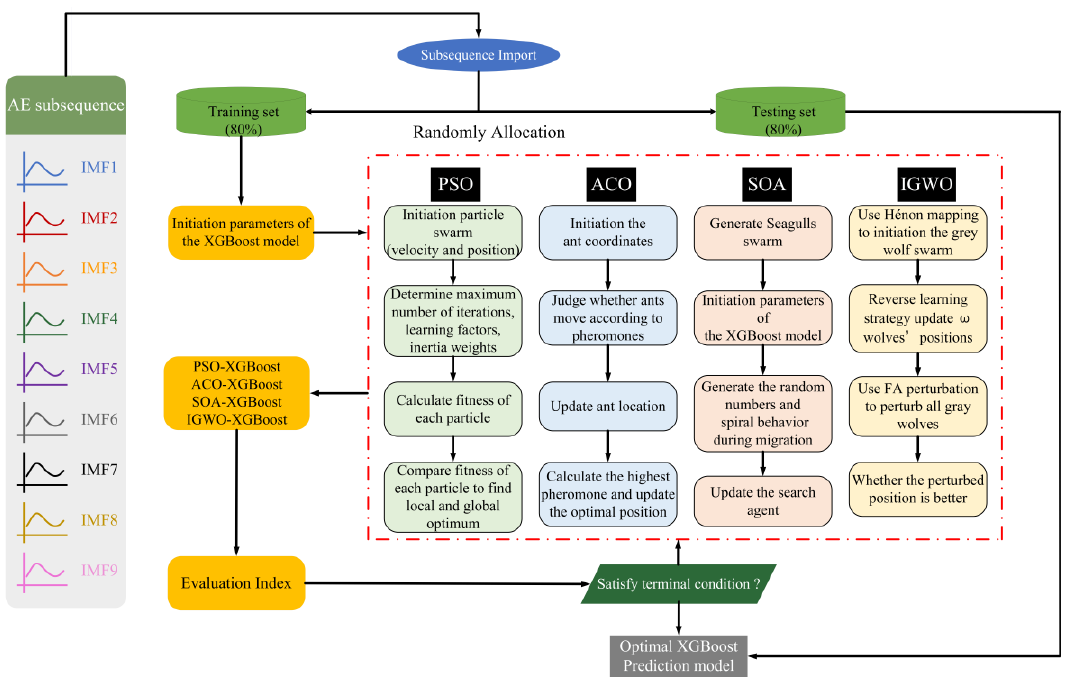
Figure 4. Optimization process of xgboost of four hybrid intelligent models based on ACMD method.